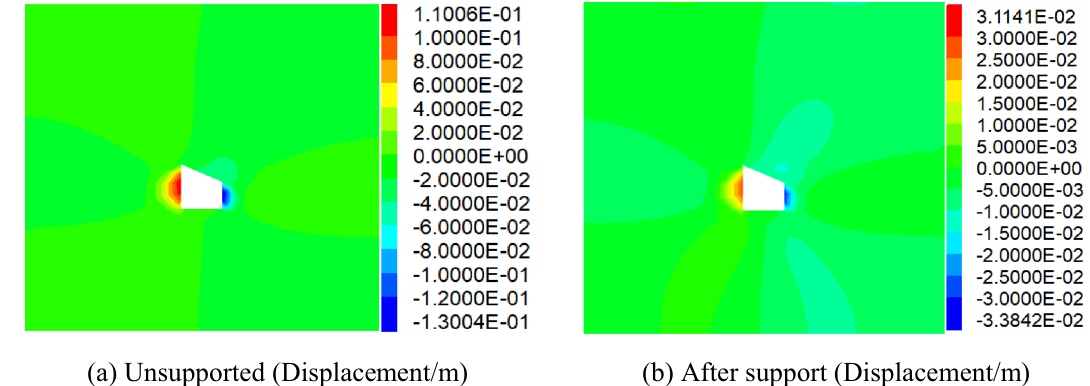
Figure 27. Horizontal Displacement nephogram of the roadway.